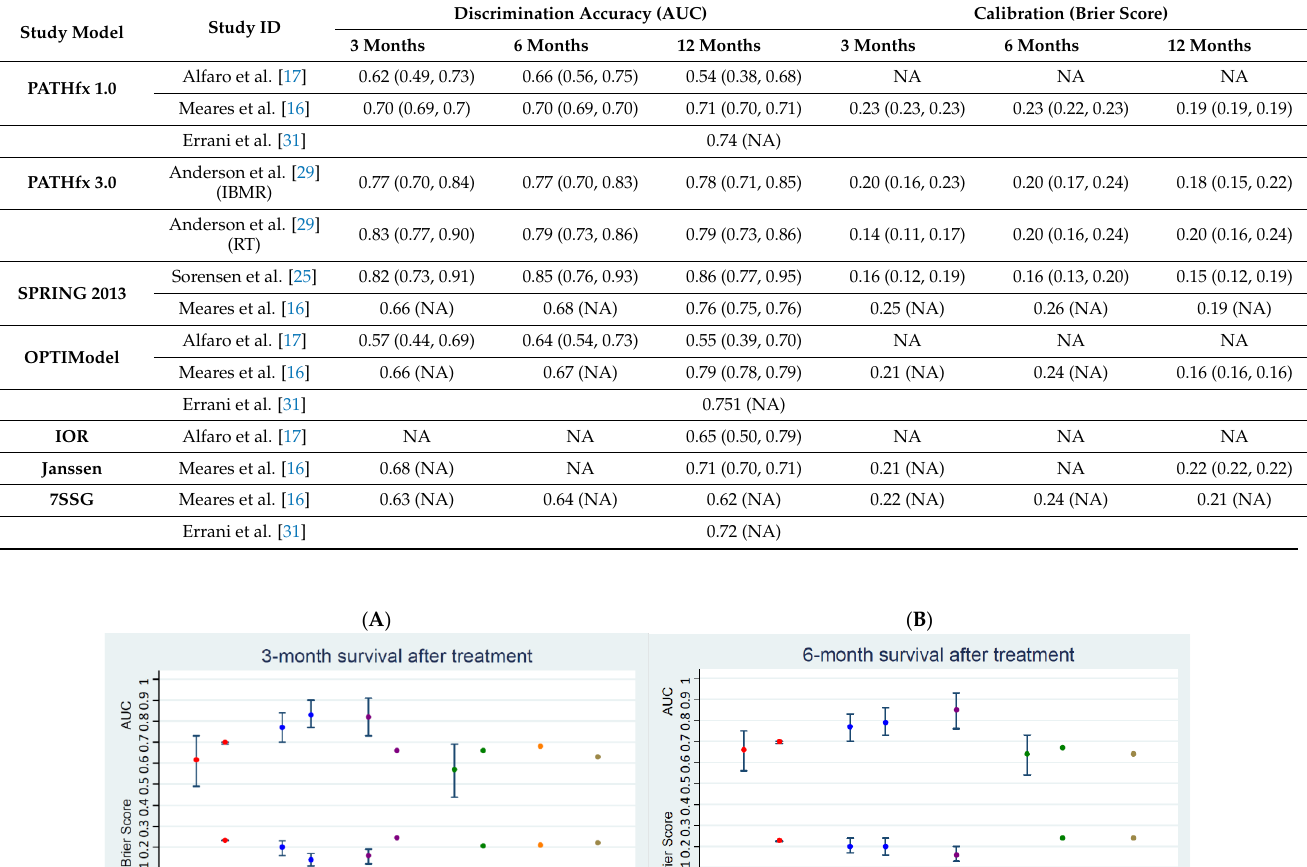
Table 2. Summary of performance metrics of externally validated models.